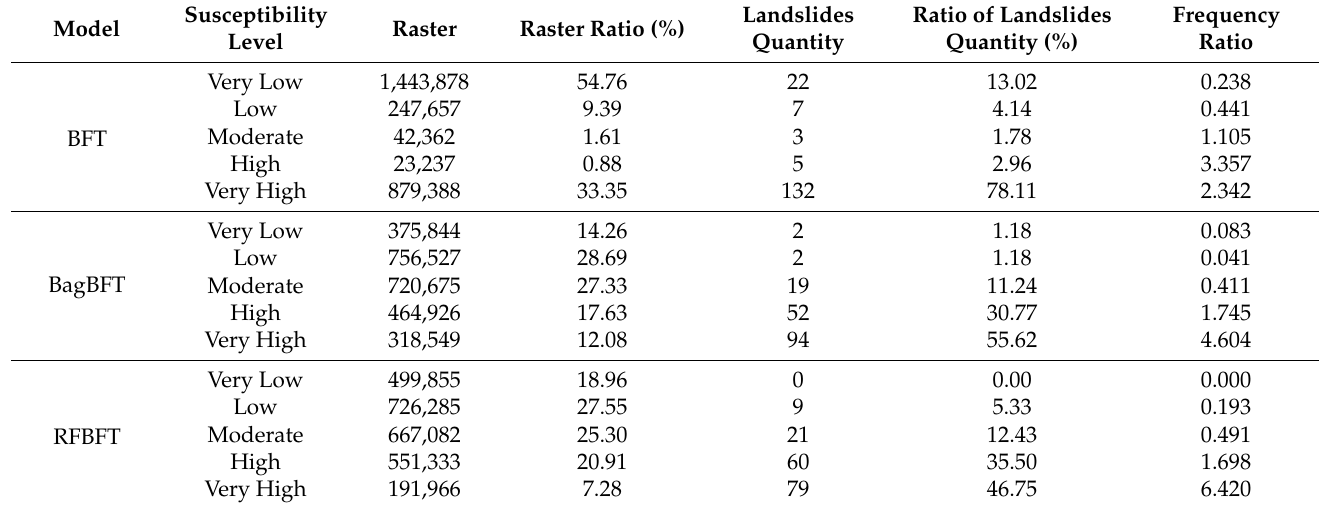
Table 5. Frequency ratio accuracy analysis of susceptibility figures of BFT, BagBFT, and RFBFT